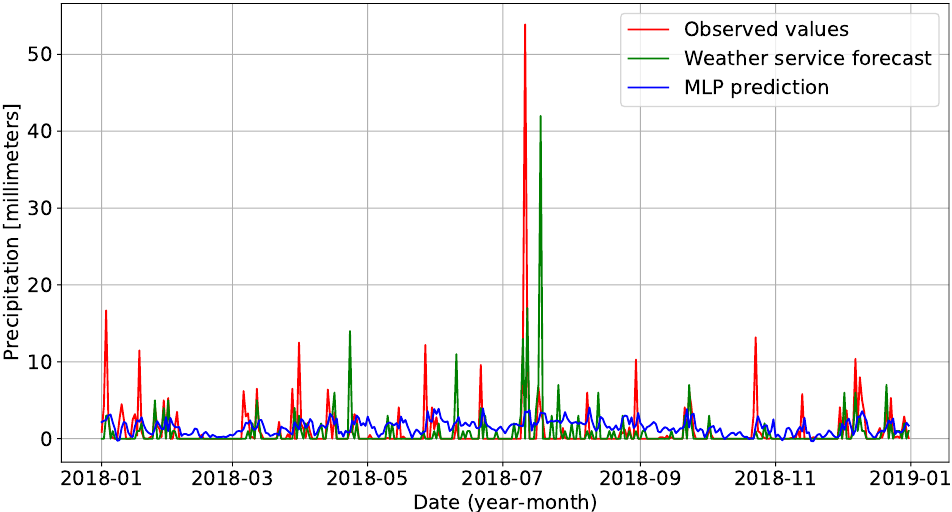
Figure 7. Comparison between the observed values and those predicted by the MLP and the weather service mean